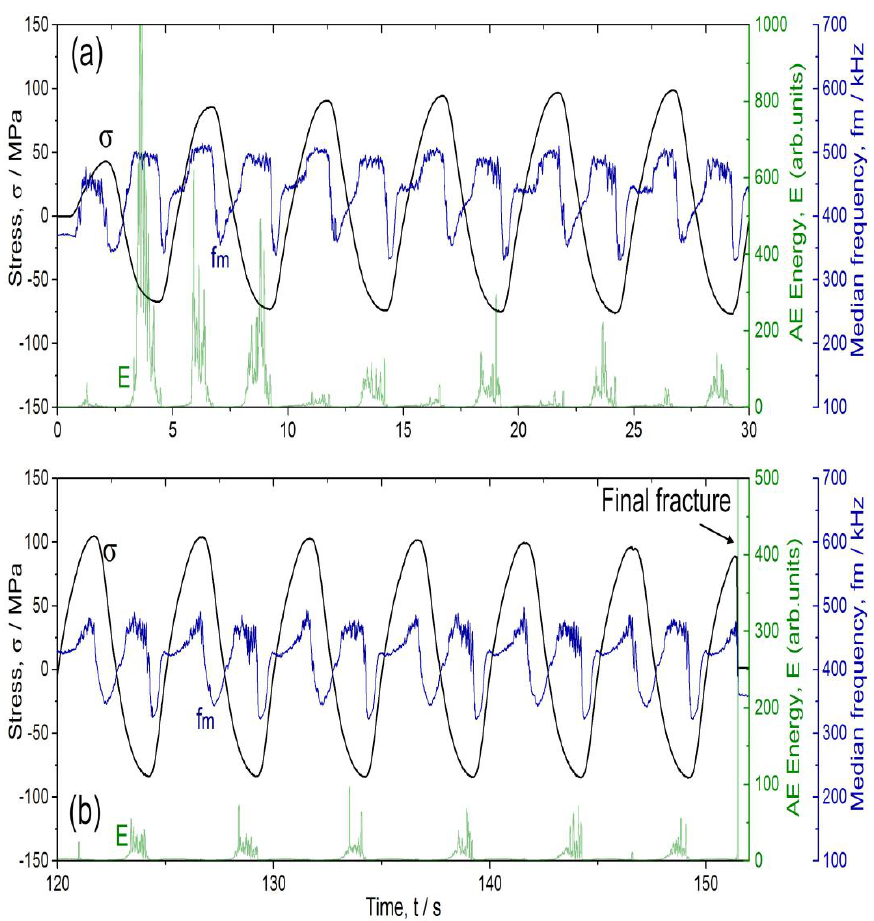
Figure 4. Acoustic emission spectral parameters—energy E and median frequency f m of the Power Spectral Density (PSD)—plotted as a function of time during early rapid hardening stage ( a ); and late deformation stage ( b ) of the ZX40 alloy (Mg-4Zn-0.16Ca tested at Δε t /2 = 1 × 10 −2 ).